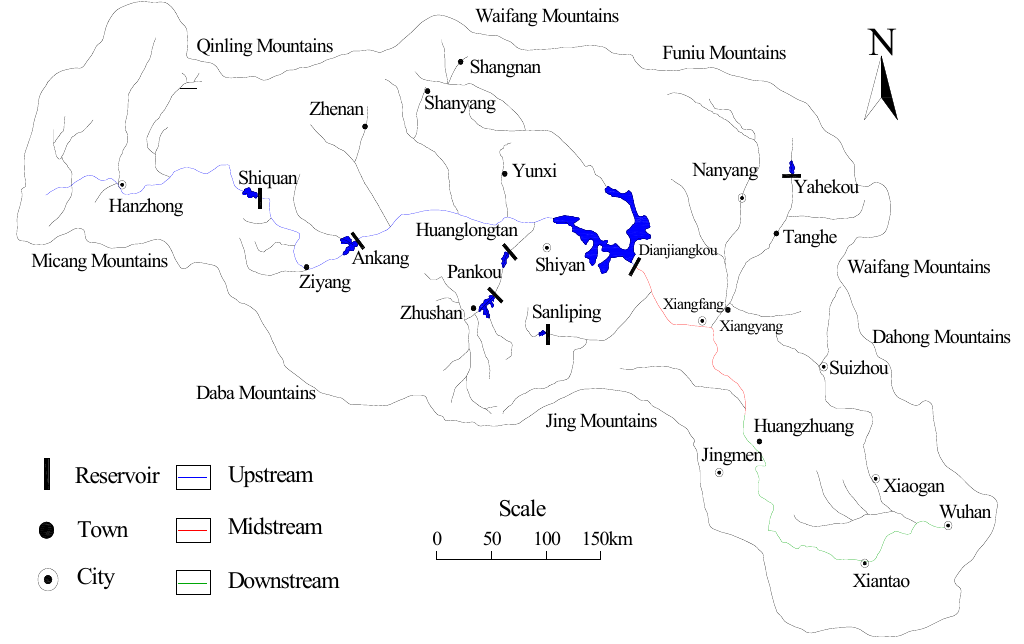
Figure 3. The schematic diagram of the Hanjiang Basin.